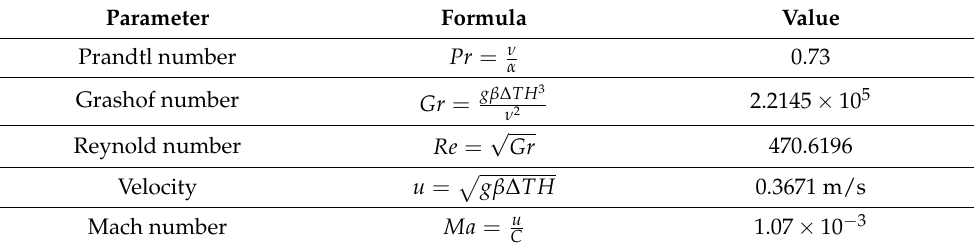
Table 2. Parameters and dimensionless numbers of the example. g = 9.81 m/s 2 is the gravity and C = 343 m/s is the speed of